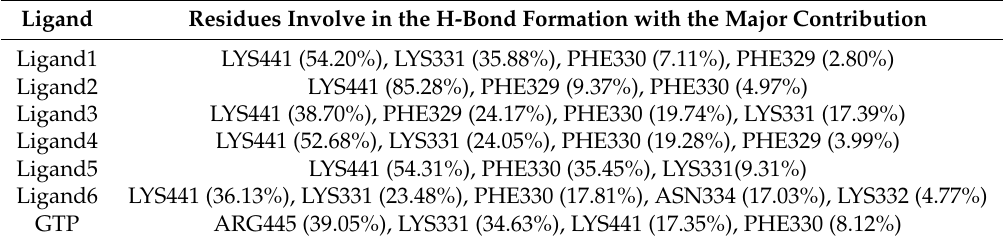
Table 4. Residues involved in the H-bond formation with percentage of how long this bond was present during the entire 10 ns of simulation.